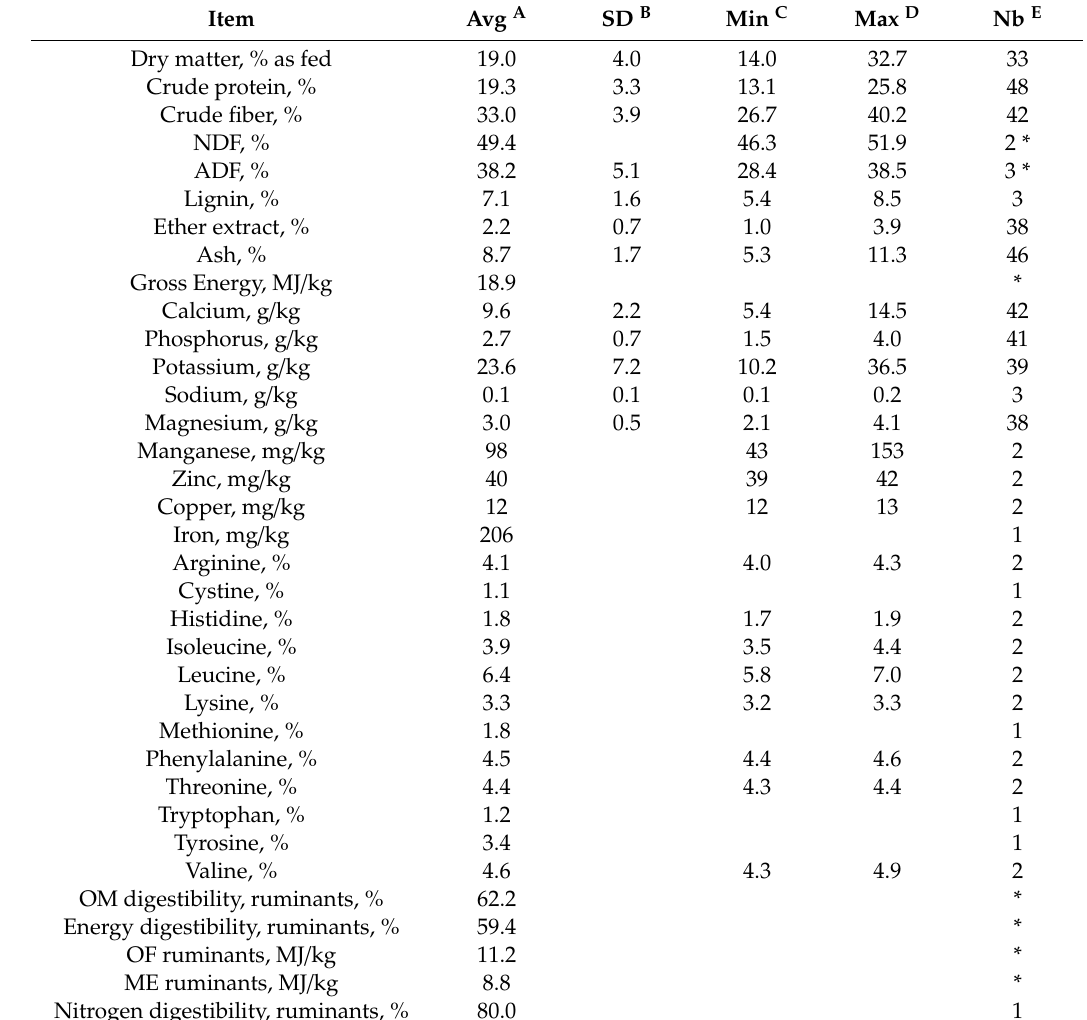
Table 9. Chemical composition and nutritional value of tropical kudzu ( Pueraria phaseoloides ), aerial part, fresh (DM basis)